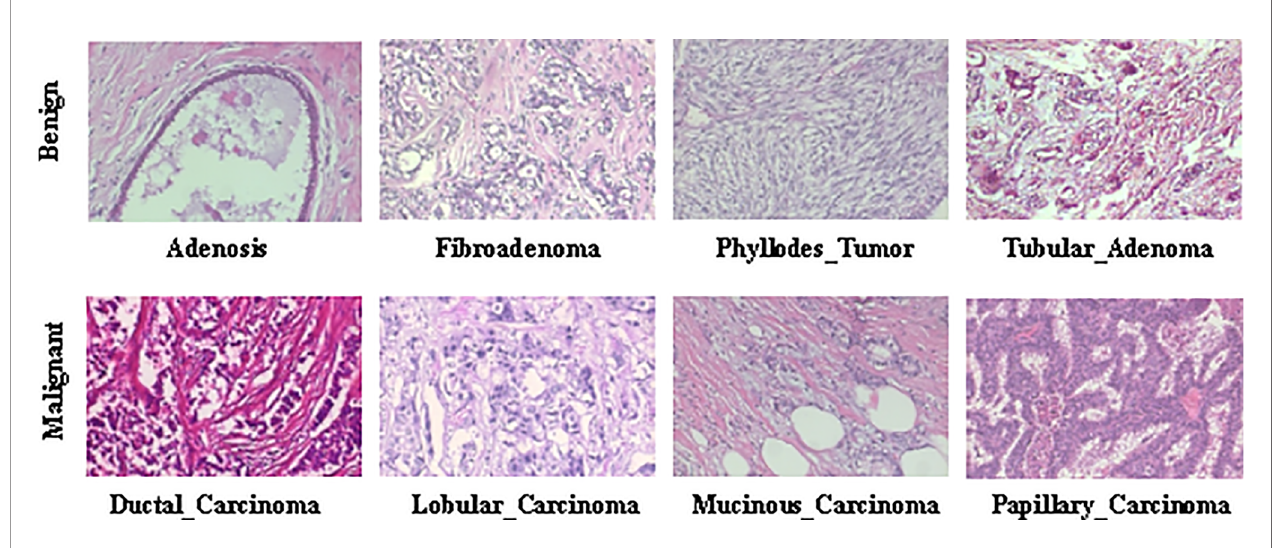
FIGURE 2 | Representative examples of BreaKHis